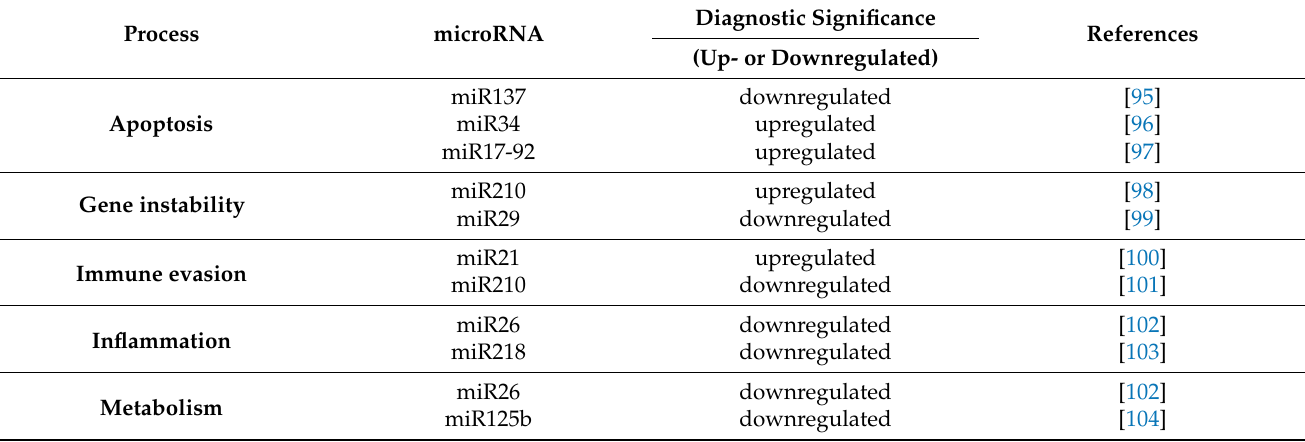
Table 2. Examples of miRNAs involved in the development of head and neck squamous carcinoma (HNSCC).